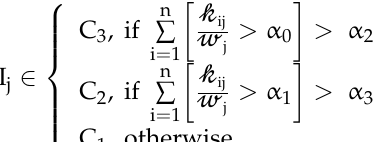
7 of 16 Interferogram score ( 𝐒 𝐢𝐧 ) − a score assigned to interferograms. It indicates the global effect of PhU errors per interferogram. If needed, the interferogram scores would be used to exclude affected interferograms, if any, and hence to update the network and recompute the estimation. Image score ( 𝐒 𝐢𝐦 ) − a score assigned to images. As with the case of interferograms, S (cid:2919)(cid:2923) shows spatially global effects. This score could also be used to remove one or more images, adjust the network and recompute the estimation. Point score ( 𝐒 𝐩𝐭 ) − a score assigned to each measurement point. It defines spatially local and temporally global characteristics of a point. The score also provides supplementary information in the interpretation of TS results by separating reliable points from unrelia- ble ones. TS scores ( 𝐒 𝐭𝐬 ) − a detailed score associated with each date of SAR image acquisitions within a given TS of a point. This score indicates temporally local as well as spatially local effects of PhU error influences. Let 𝓂 , ℓ and 𝓃 , respectively, refer to the number of images, the number of inter- ferograms and the number of points processed. Automatic assignment of the above scores for interferograms, images, points and TS thus involves the following steps: 1. Computing residuals from the first LS estimation Equation 4. 5. Computing residuals from the first LS estimation Equation 4.